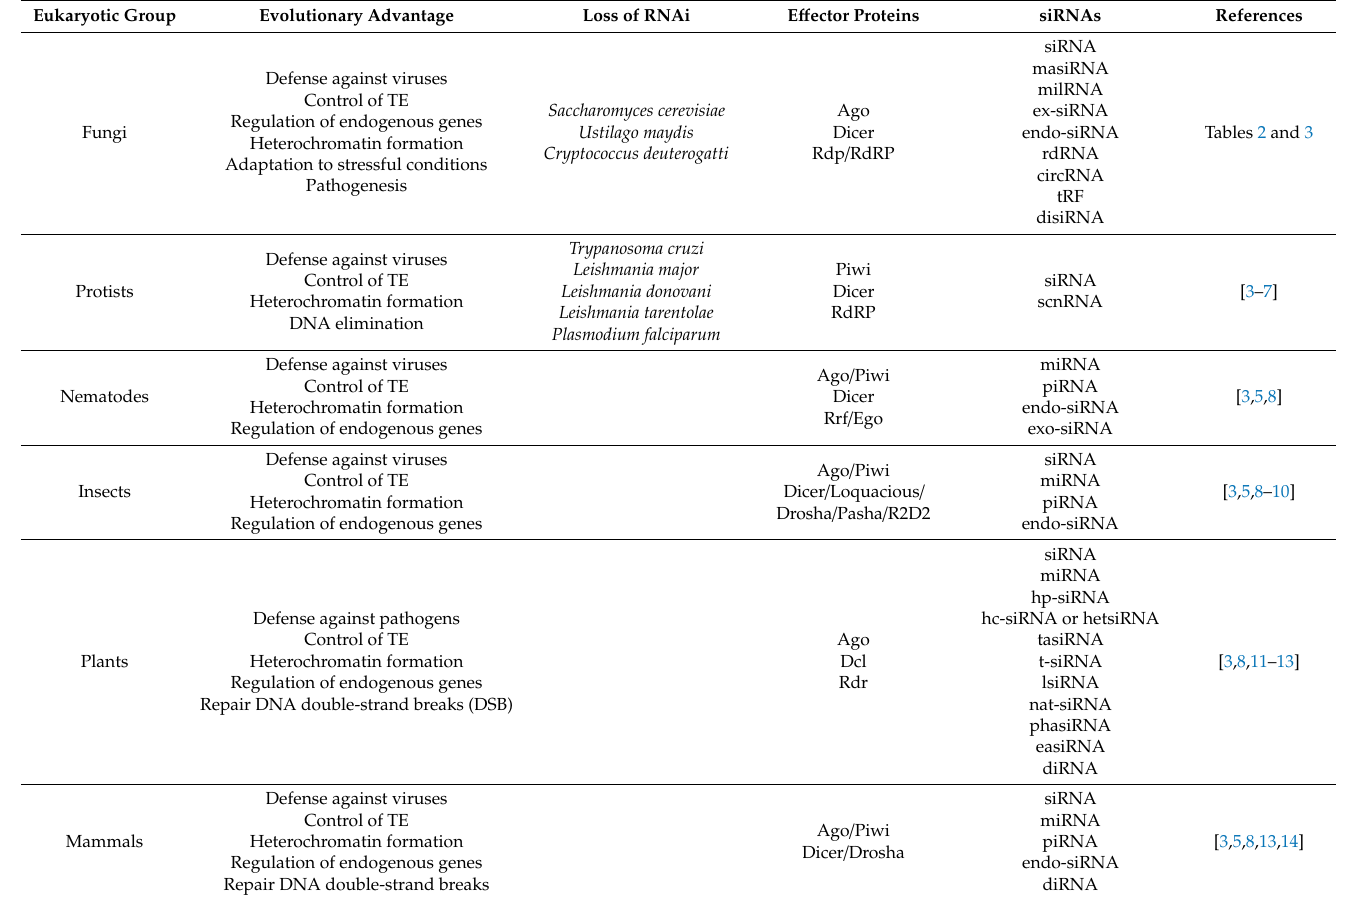
Table 1. RNA interference (RNAi) mechanisms in